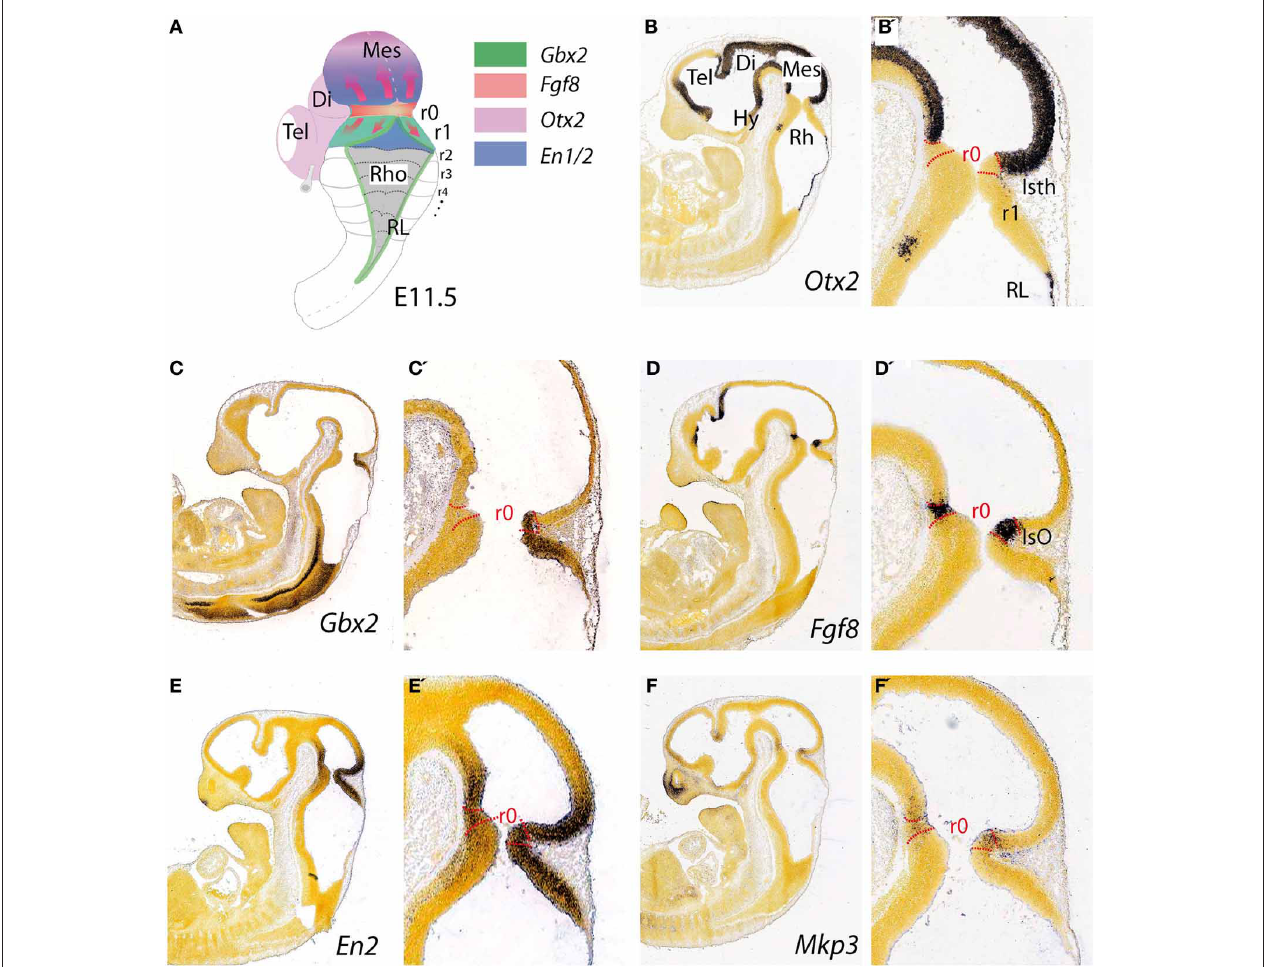
FIGURE 1 | Topographical location and main molecular characterization of the mid-hindbrain boundary at E11.5. (A) A dorsal view of an E11.5 mouse embryo illustrating the isthmic constriction (isth) located between the mesencephalon and rhombomere 1 (r1). Moreover, rhombomeres, r0 and r1, which give rise to the cerebellum are highlighted in (A) . The different color codes depict the expression pattern of the most important genes related to